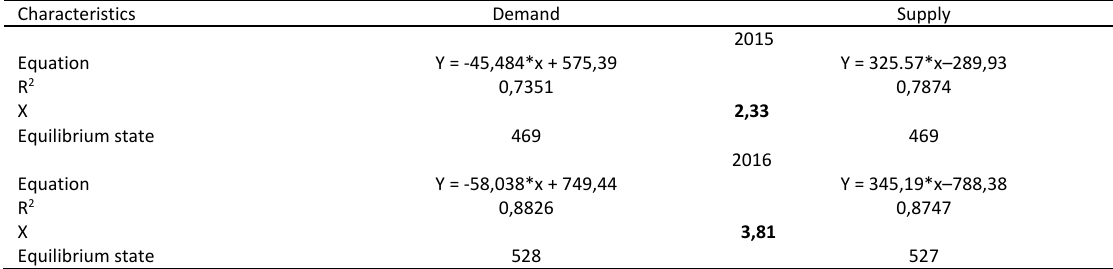
Table 6: Characteristics of the equilibrium state in the milk market under research conditions for 2015-2016